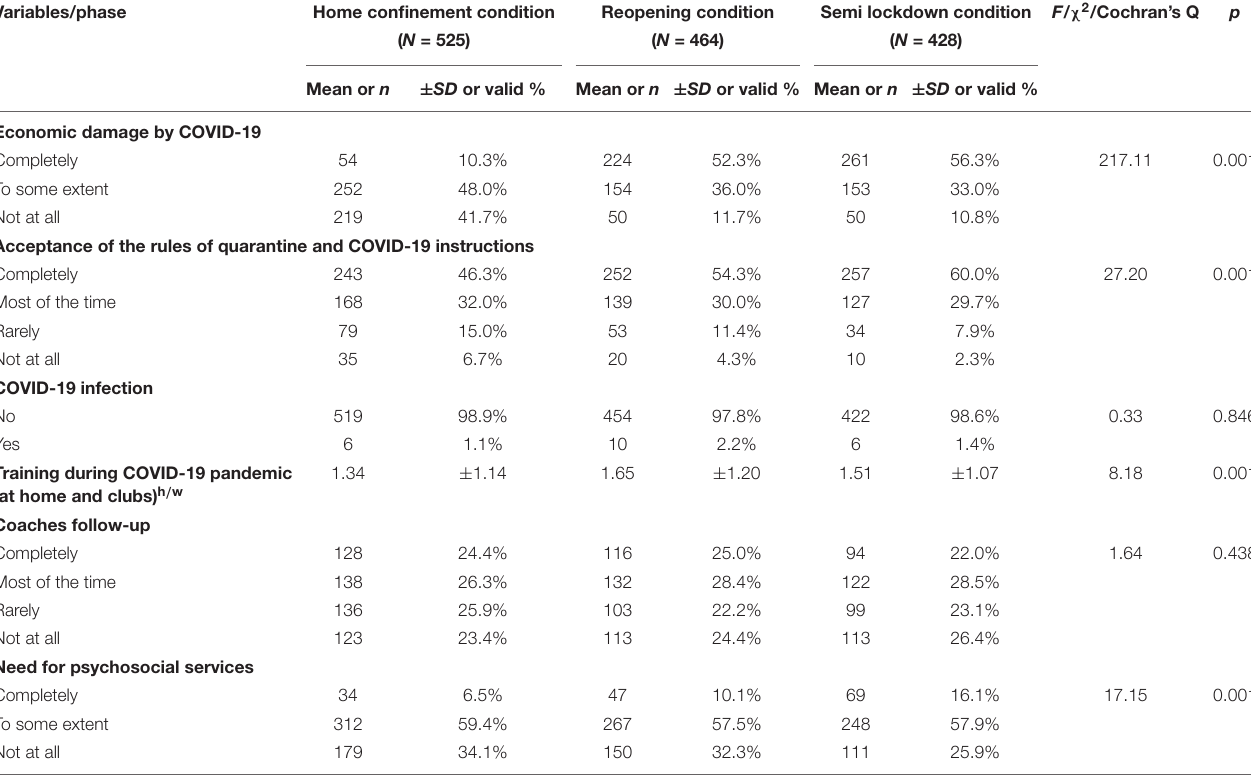
TABLE 2 | COVID-related characteristics influencing the participants during the three phases of study.